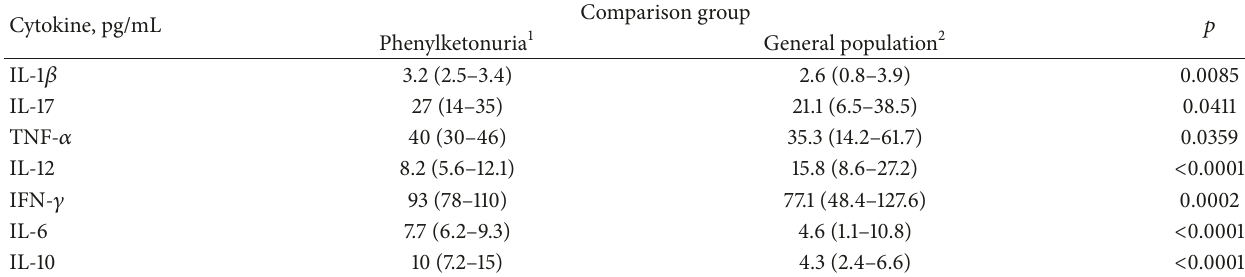
Table 4: Plasma cytokine concentrations in participants with phenylketonuria consuming AA-MF compared to a general population. Cytokine, pg/mL